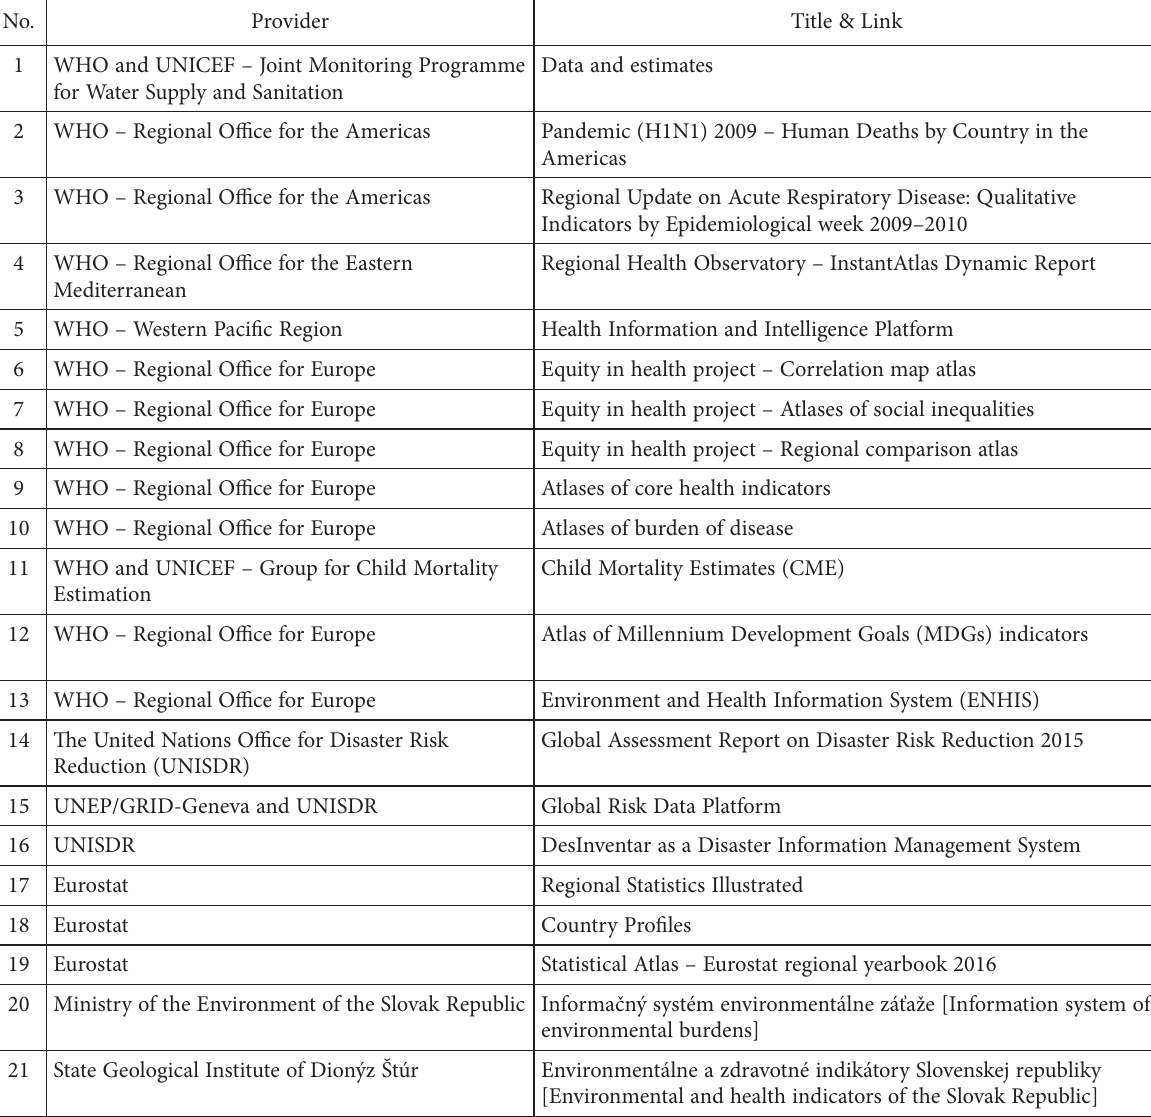
Table 1. List of the analysed web mapping applications